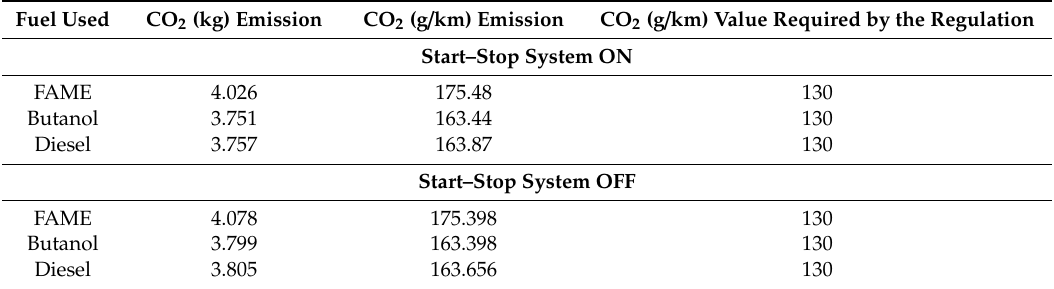
Figure 8. Fuel consumption as a function of the share of an additive (( a )—start–stop ON, ( b )—start–stop OFF). Table 7. List of CO 2 emission results for the individual fuels with values from